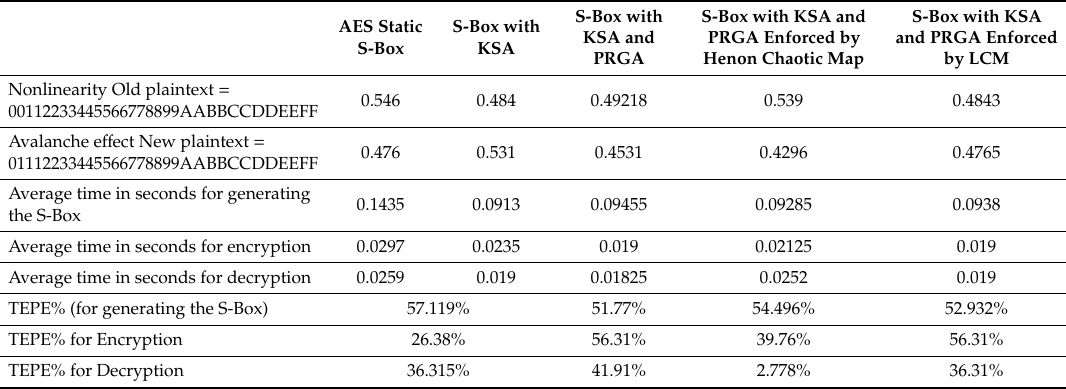
Table 5. Results of the security tests with key “FEDCBA9876543210”. AES Static S-Box with S-Box